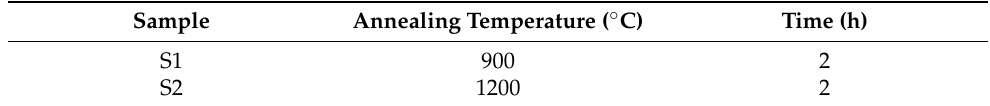
Table 1. Annealing parameters of sprayed